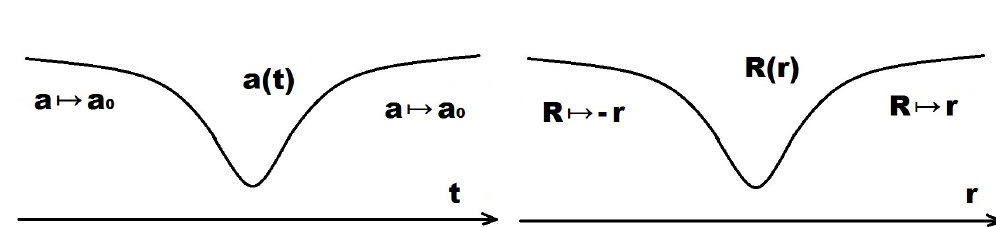
Figure 1. Time dependence of the scale factor of a bouncing solution ( a ) and a wormhole profile ( b